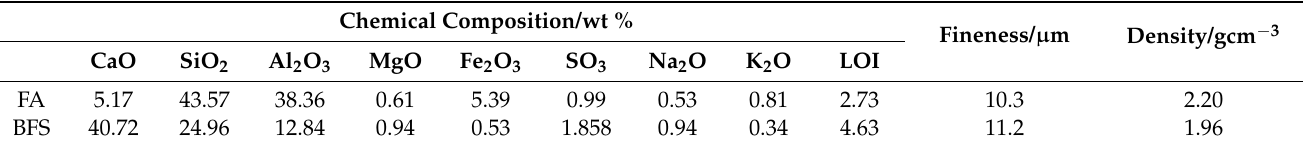
Table 1. Properties of raw